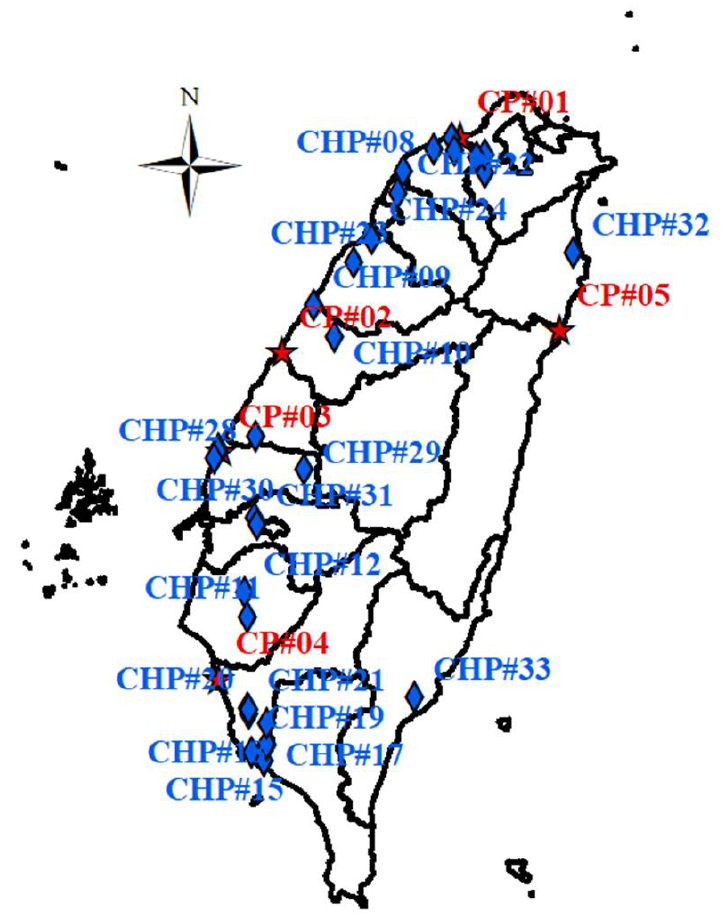
Figure 1. Locations of coal-fired power (CP) and combined heat and power (CHP) plants in Taiwan. A total of 21 and 65 generators were installed in 5 CP and 33 CHP plants, respectively.